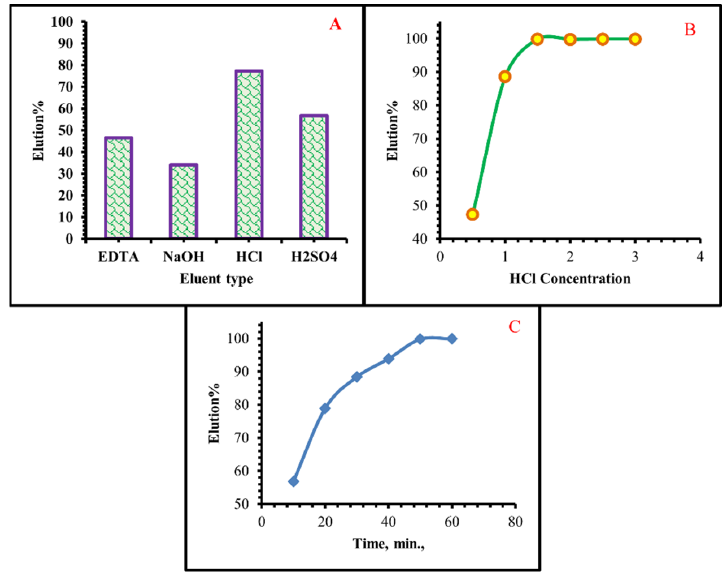
Figure 15. ( A ) Elution results of Cr(VI) from TIHP Surface at various eluting agents ( B ) At different HCl Concentrations ( C ) At the different times.